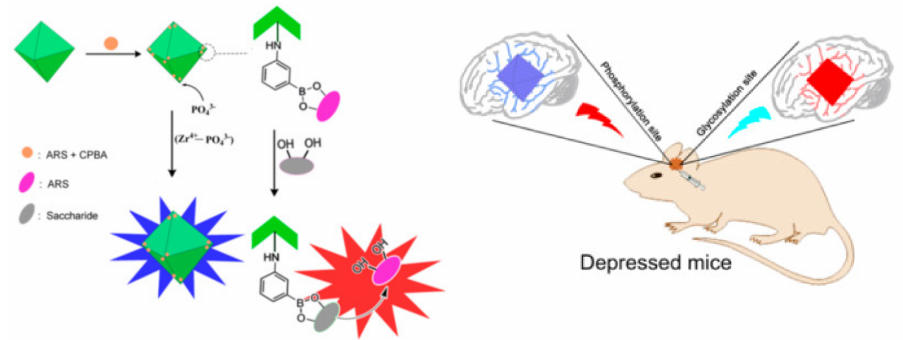
Figure 15. Schematic illustration of the proposed mechanism of MOFs-based detection of the levels of glycosylation and phosphorylation (left) and in-situ fluorescence imaging of the levels of glycosylation and phosphorylation in depressed mice (right). Reproduced with permission [197]. Copyright 2020, American Chemical Society.